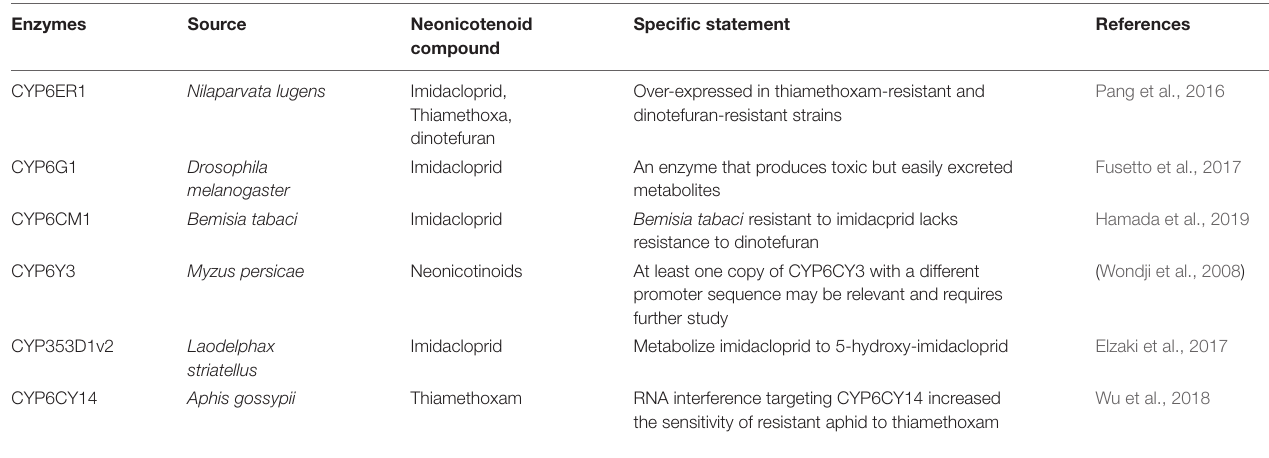
TABLE 4 | Enzymes reported for the degradation of neonicotinoid